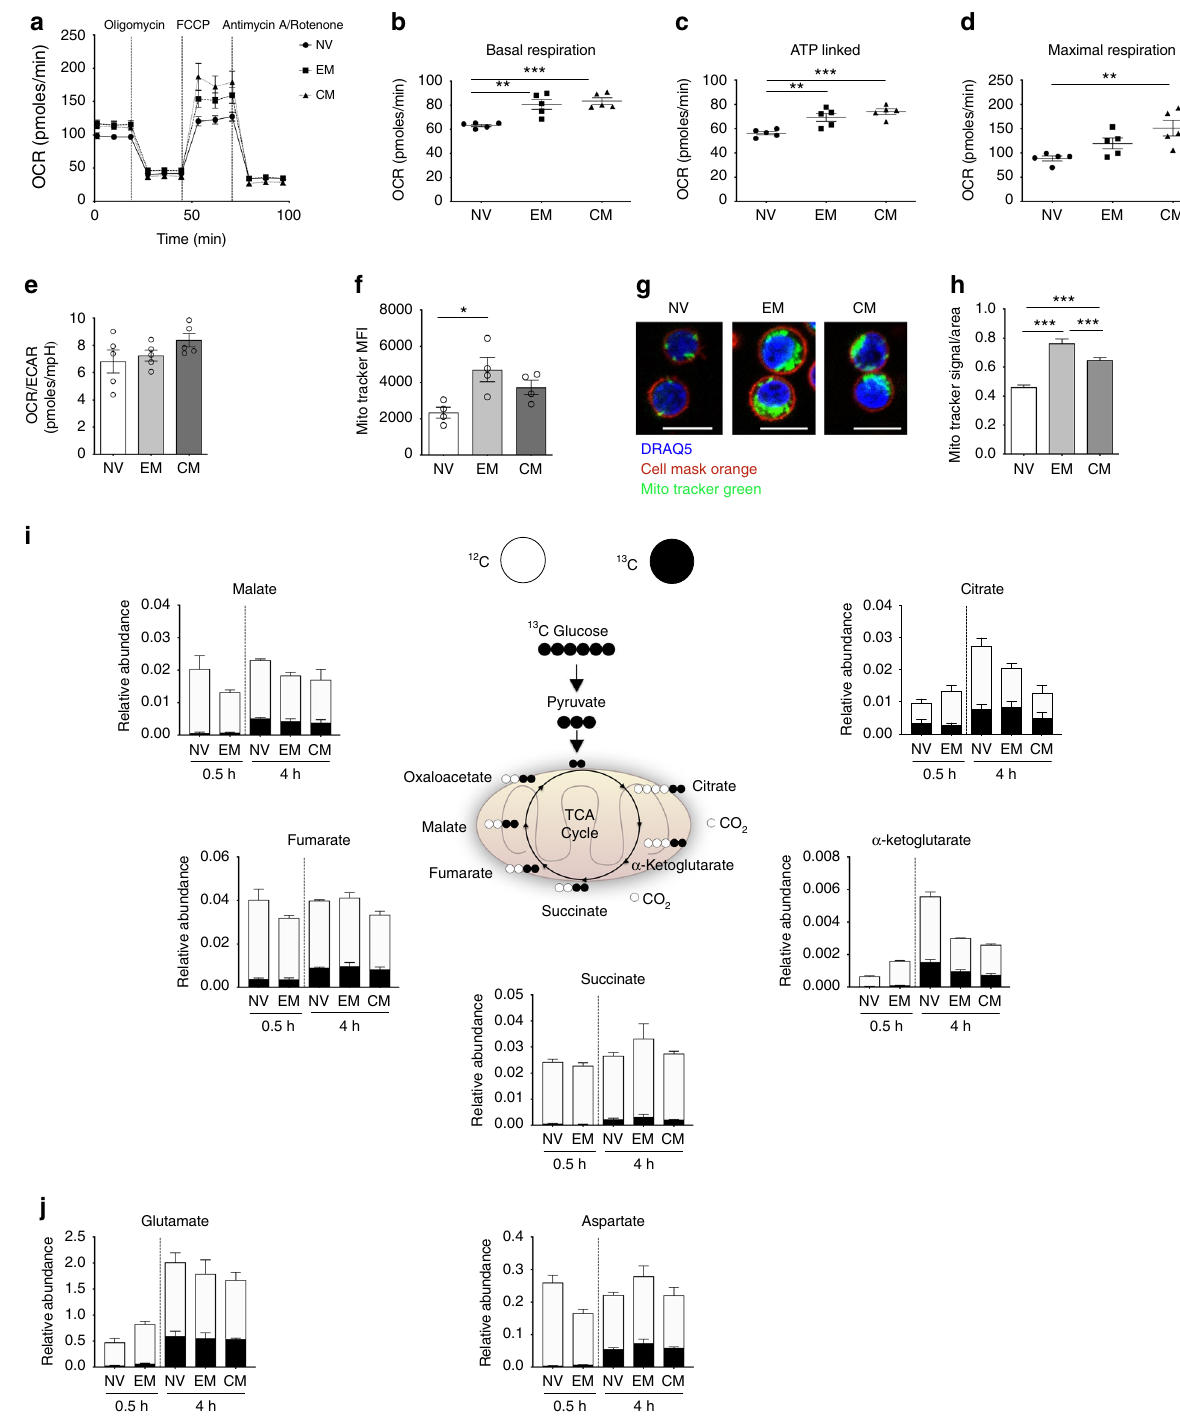
Fig. 2 Activated CD4 + T-cell subsets incorporate glucose into the TCA cycle. a Oxidative phosphorylation pro fi le of NV, EM and CM T- cells by measuring OCR before and following injections of oligomycin (0.75 μ M), FCCP (1 μ M) and antimycin A and rotenone (1 μ M). Basal respiration ( b ), ATP-linked respiration ( c ), maximal respiration ( d ) and OCR/ECAR ratio ( e ) in NV, EM and CM T- cells. f Mitochondrial content of NV, EM and CM CD4 + T-cells measured using MitoTracker. g Representative images of NV, EM and CM T-cells stained with DRAQ5 (nucleus), cell mask orange (plasma membrane) and MitoTracker green (mitochondria) scale bar = 10 μ m and h corresponding MitoTracker signal to area ratios. i Uniformly labelled 13 C-glucose incorporation into T-cell metabolites via the TCA cycle in NV, EM and CM T-cells activated for 0.5 and 4 h. Relative abundance of 12 C and 13 C including citrate, α -ketoglutarate, succinate, fumarate and malate. j Relative abundance of 12 C and 13 C in non-essential amino acids glutamate and aspartate . Data are representative of either fi ve independent experiments ( a – e ), four independent experiments ( f ), three experiments with <100 cells analysed as technical replicates ( h ) or three independent experiments ( i , j ). Statistical analysis was performed using a nonmatching one-way ANOVA with Tukey ’ s multiple comparison test ( b – h ). For non-parametric data, a Kruskal − Wallis test with Dunn ’ s multiple comparisons test was used. Data expressed as mean ± SEM; * p ≤ 0.05, ** p ≤ 0.01, *** p ≤